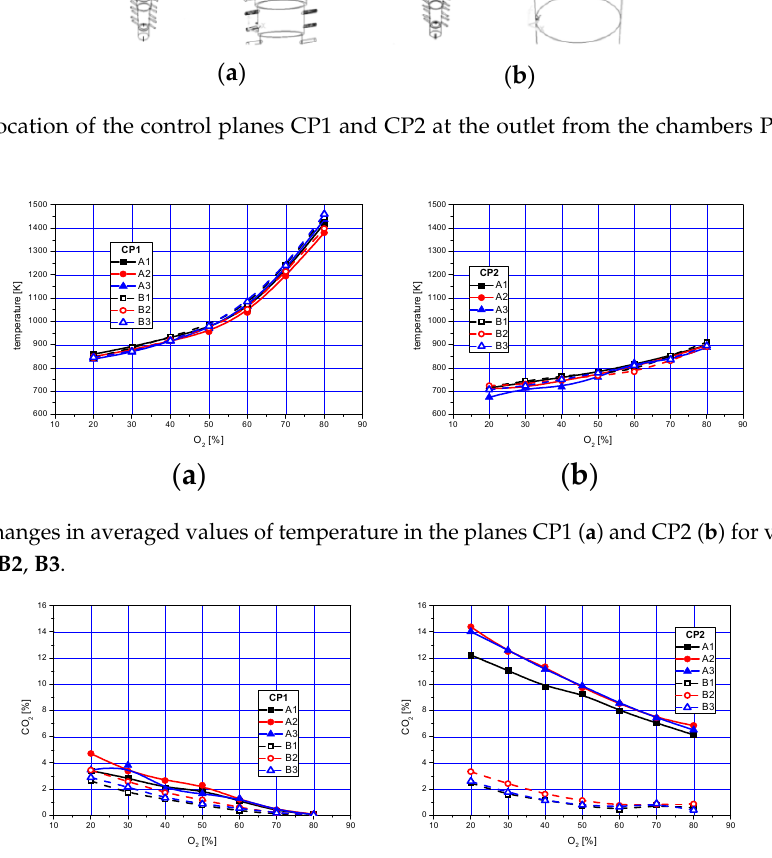
of CO 2 , ( k ) content of CO, ( l ) content of H 2 .